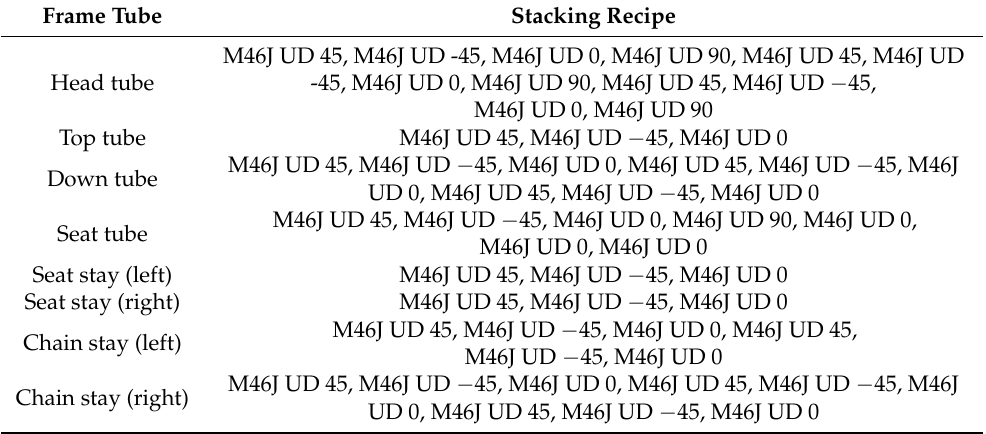
Table 8. Stacking scenario